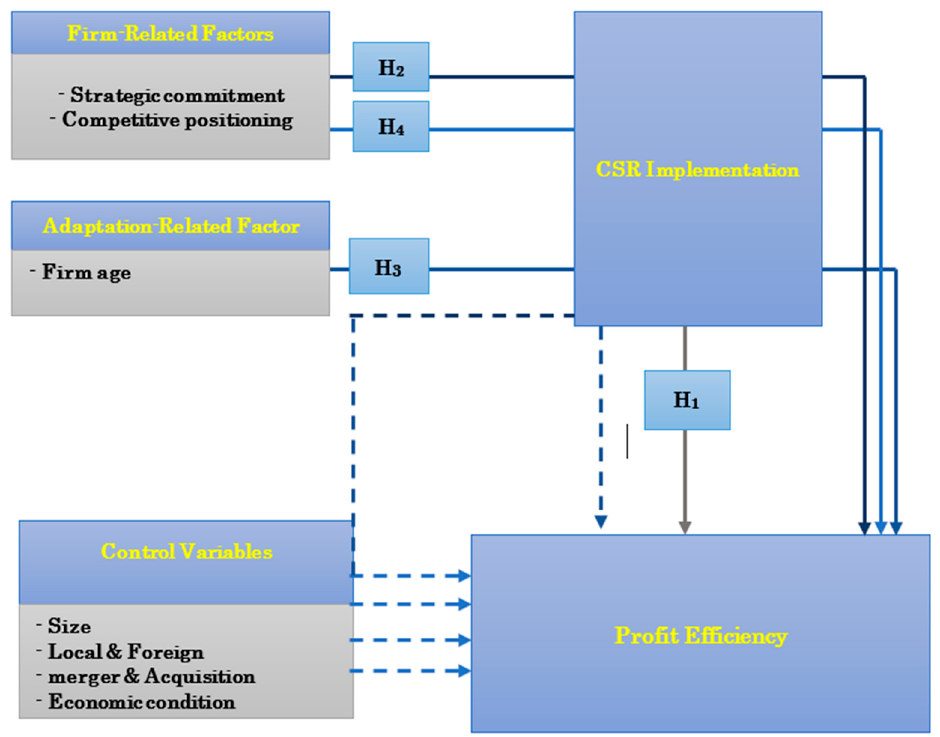
Figure 1. Conceptual model of CSR effects and its drivers on profit efficiency. Notes: Solid lines represent measured constructs and empirically tested relationships; dotted lines represent theorized constructs and control variables.